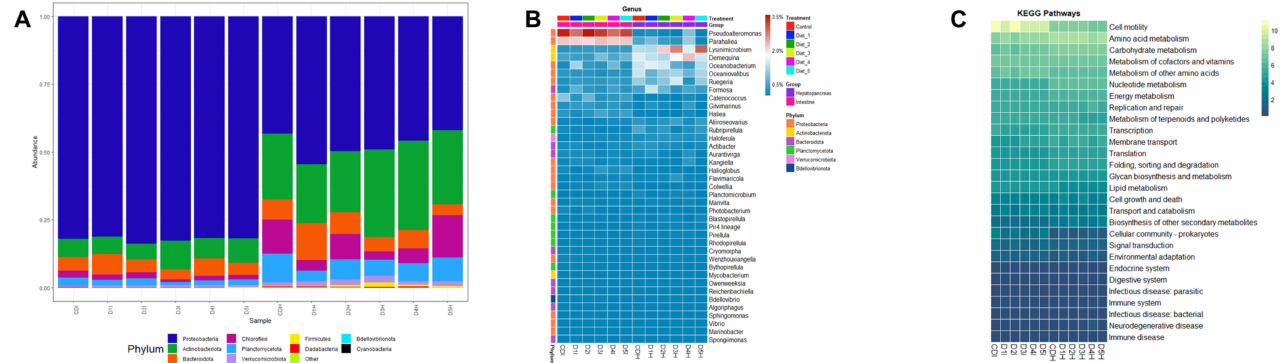
Figure 5. Prokaryotic microbiota of intestines and hepatopancreas from shrimp fed control diet and 50% fishmeal replacement diets. ( A ) Top ten of phyla abundance. ( B ) Heatmap analysis of top 40 genera, and ( C ) Heatmap analysis of function prediction based on KEGG pathways analysis. Abbreviations: intestine (I) and hepatopancreas (H). CD (200 g/Kg FM), D1 (0.13% DL-MET), D2 (0.06% MET-MET), D3 (0.19% MET-MET), D4 (0.13% DL-MET plus 0.10% B. amyloliquefaciens CECT 5940) and D5 (0.06% MET-MET plus 0.10% B. amyloliquefaciens CECT